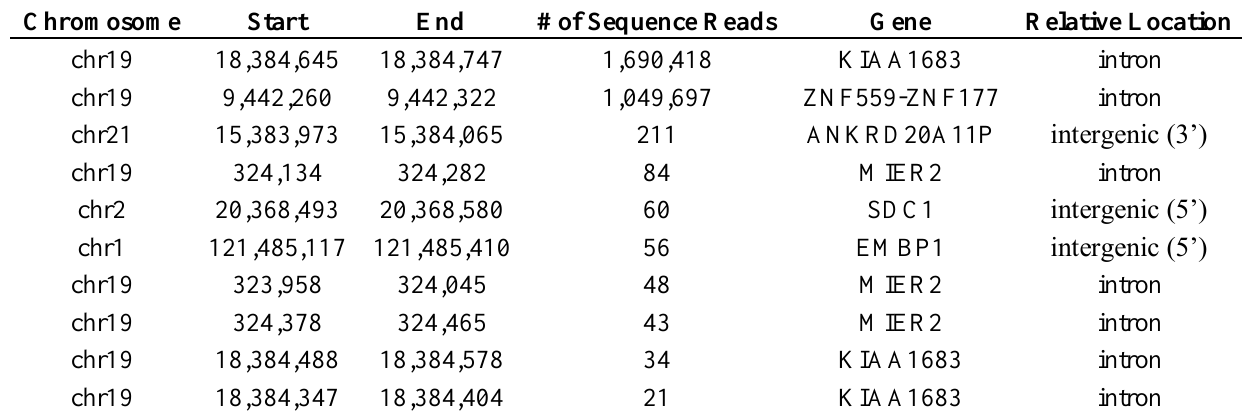
Table 1. Integration site analysis of blood from UPN0306 during